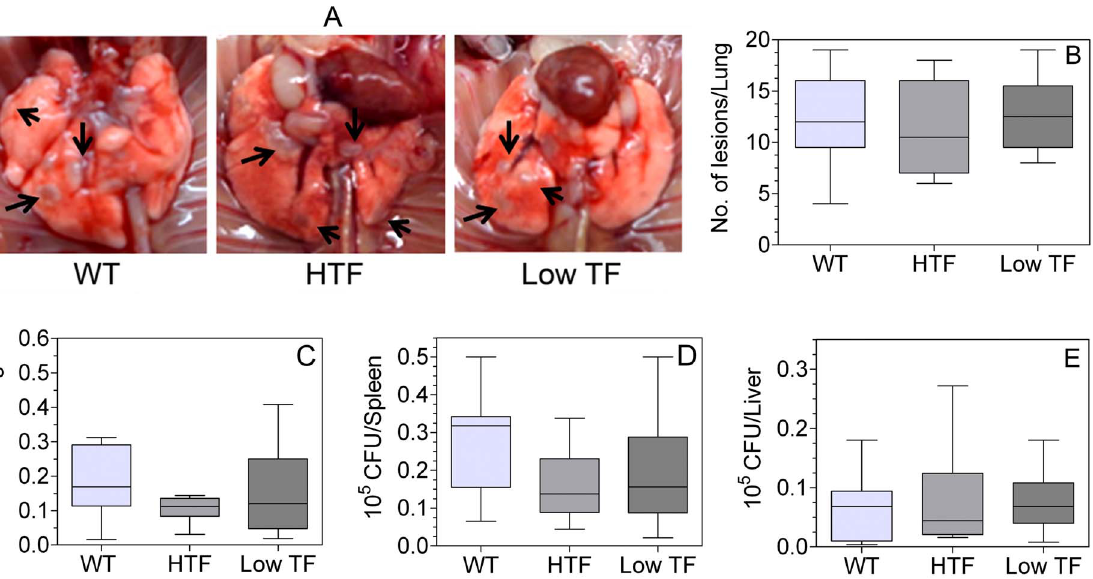
Figure 2. TF deficiency does not affect lung lesions, mycobacterial growth and dissemination in mice infected with M.tb. ( A ) Representative images of whole lungs after 8 weeks of M.tb aerosol exposure showing grey-white nodule like lesions (arrow marks). ( B ) Visible lesions on the lung surface of each lobe were counted and shown as an average plot. Mycobacterial burden in lungs ( C ) and dissemination into spleen ( D ) and liver ( E ) was determined as described in methods. Data are representative of three independent experiments (total n 5 9–19 per group). No significant differences were found among the